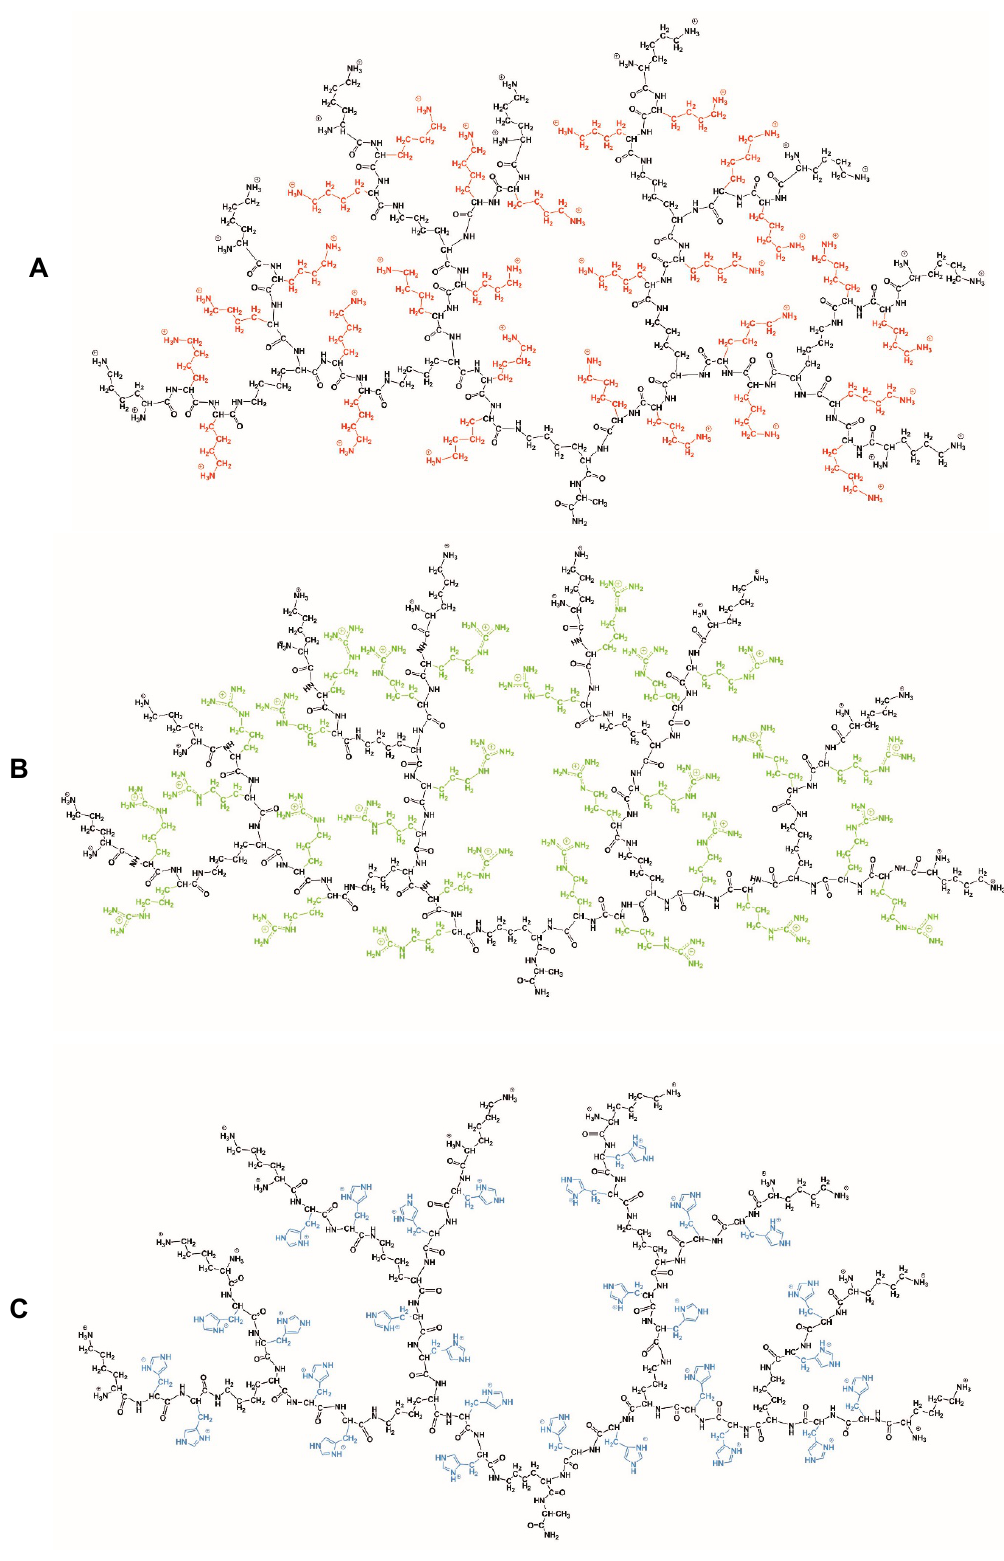
Figure 1. Chemical structures of D3K2 ( A ), D3R2 ( B ), and D3H2 ( C ) dendrimers. The backbone, identical for all dendrimers, is marked in black. The side groups of spacers between each pair of neighboring branching points are marked in red (lysine), green (arginine), and blue (histidine). Substitution of lysine residues with different amino acids may bring several benefits to PLL dendrimers considered as a system for gene delivery, changing their flexibility and distribution of charged groups, providing additional interactions with nucleic acids, and affecting cellular uptake levels [24,33–35]. Both lysine and arginine are charged aliphatic amino acids with amino groups that are protonated under biological conditions, which may ensure the efficient delivery of nucleic acid into the cells and its endosomal escape. It has been shown that the insertion of Arg residues between inner Lys branching points made the dendrimer’s interior more charged and thus more hydrophilic [34]. What is more, a guanidine moiety of Arg shows high affinity for phosphate groups of DNA, increasing its condensation. On the other hand, His contains an aromatic imidazole group, which can be either cationic or neutral at different pH values, potentially providing additional interactions with nucleic acids and their pH-triggered release [36].